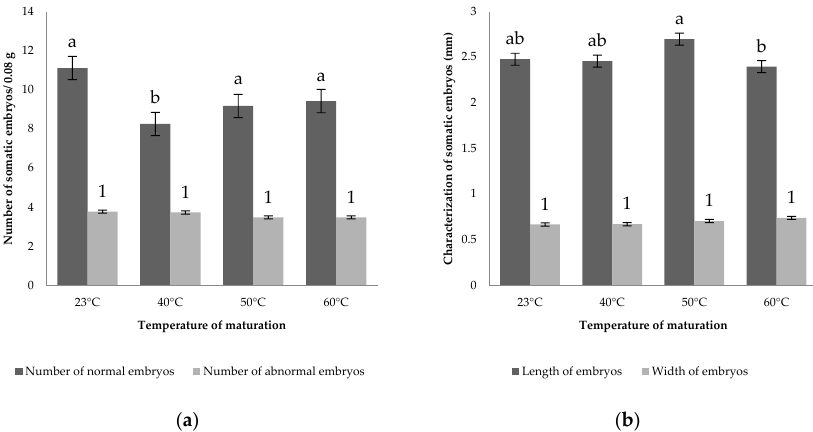
Figure 5. Somatic embryos obtained per 0.08 g of embryonal masses submitted in different maturation temperatures (23, 40, 50, and 60 °C, after 12 weeks, 90, 30, 5 min, respectively). ( a ) Number of normal and abnormal somatic embryos; ( b ) the length and width of normal embryos from Pinus halepensis Mill. Di ff erent letters or numbers show significant di ff erences according to the Tukey–Kramer test ( p ≤